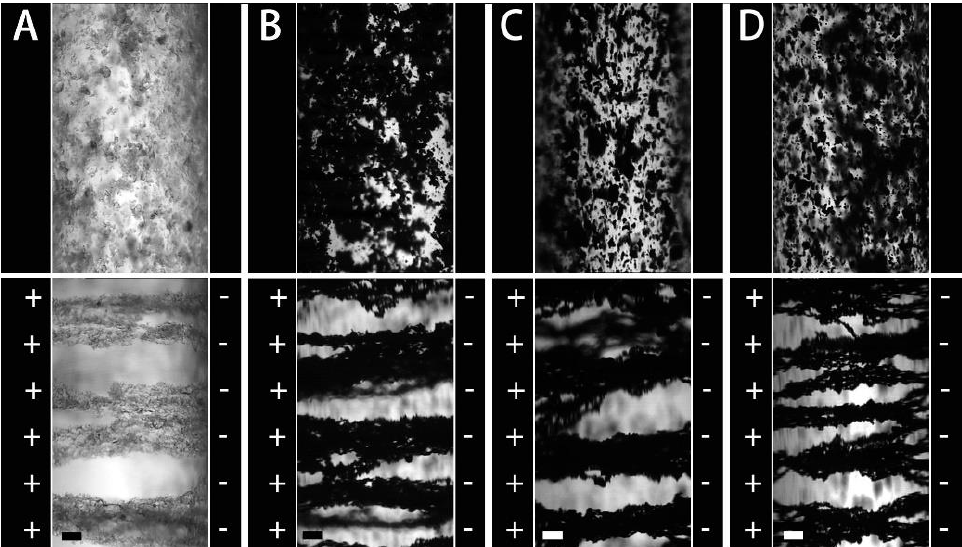
Figure 4. Optical photographs of the electrorheological (ER) fluids without and with electric field: ( A ) neat PIL, ( B ) PIL/PANI(HCl), ( C ) PIL/PANI(NH 3 ), and ( D ) PIL/PANI(N 2 H 4 ) ( ϕ =3 vol%, Scale bar = 100 μm).